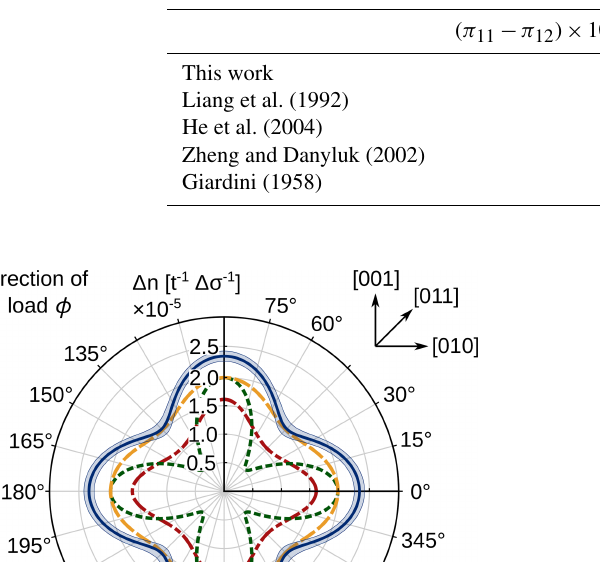
Table 1. Stress-optical coefficients for a (100) silicon from experiments in this study and from the literature.